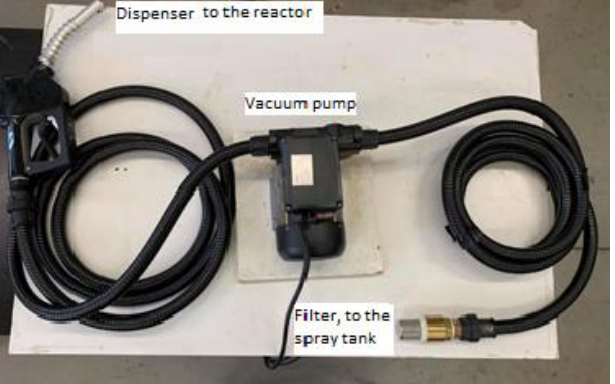
Figure 3. The vacuum pump system employed to quickly and safely transfer the pesticide solution from the spray-tank, or any other container, to the photodegradation